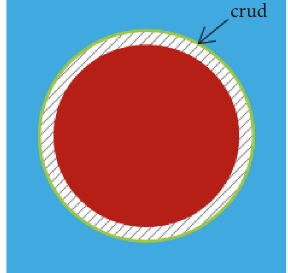
Figure 5: Schematic drawing of crud position.